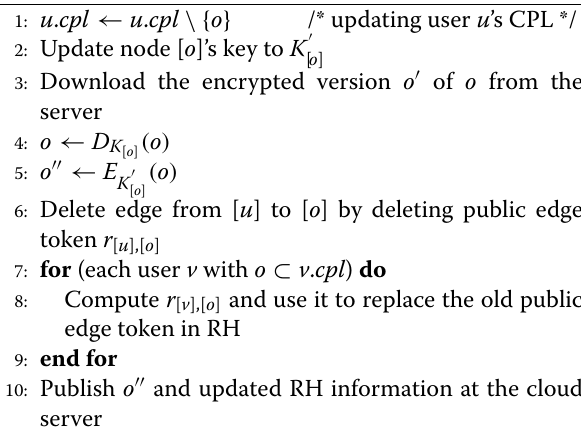
(Step 10). The updated CPL and resource hierarchy are shown in Fig. 12.